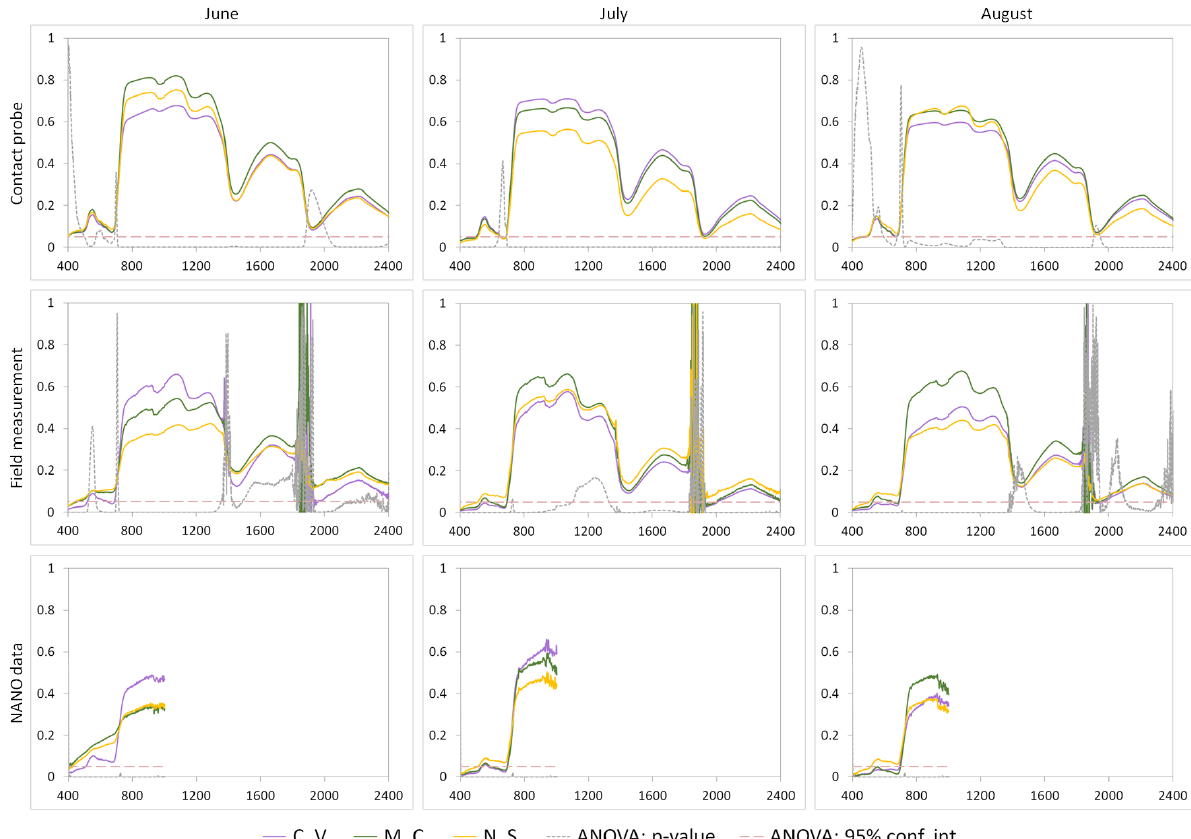
Figure 3. Median spectra and p-values of ANOVA for each species (C. V. – Calamagrostis villosa ; M. C. – Molinia caerulea , N. S. – Nardus stricta ), spectral measurement method and date. Horizontal axis is the wavelength in nanometres, vertical axis the p-value and